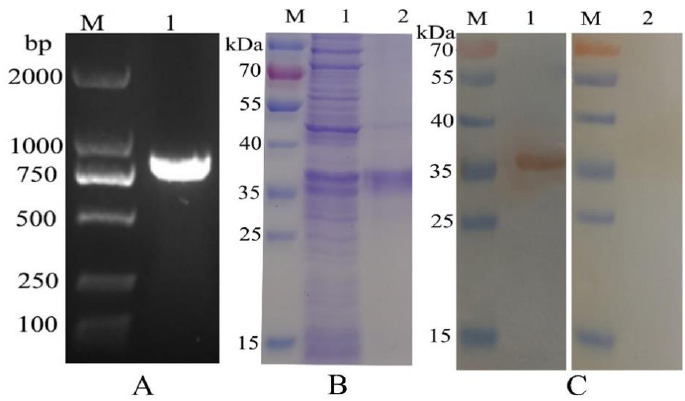
Figure 1. ( A ): PCR product of Haemonchus contortus Ephrin domain containing protein (HcEPH)